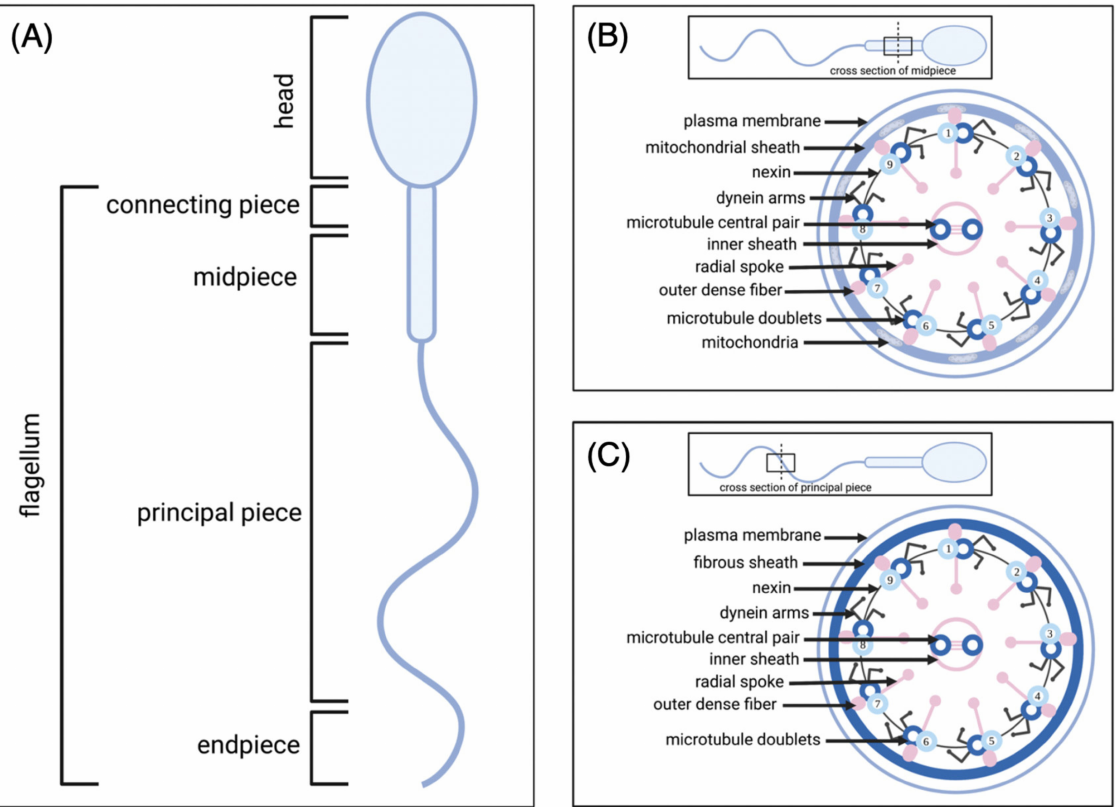
Figure 1. ( A ) mammalian spermatozoon structure. Spermatozoon are divided into two main struc- tures: the head and the flagellum. The flagellum is further divided into four ultrastructures: con- necting piece, midpiece, principal piece, and endpiece; ( B ) cross-section of the flagellum structure in the midpiece containing the axoneme surrounded by outer dense fibers, mitochondrial sheath and the plasma membrane; ( C ) cross-section of the flagellum structure in the principal piece containing the axoneme surrounded by outer dense fibers, fibrous sheath and the plasma membrane. Figures created with BioRender.com (accessed on 21 November